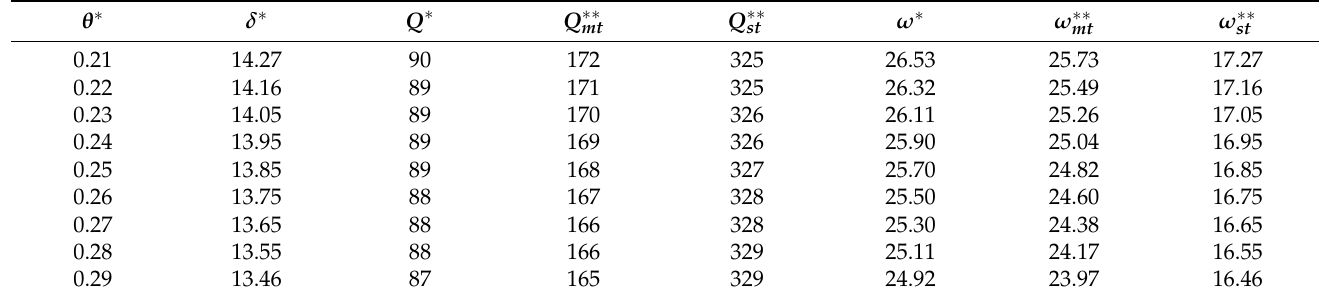
Table 1. Effects of tariff rate on order quantity and FOB price in MT and ST alliance decisions.